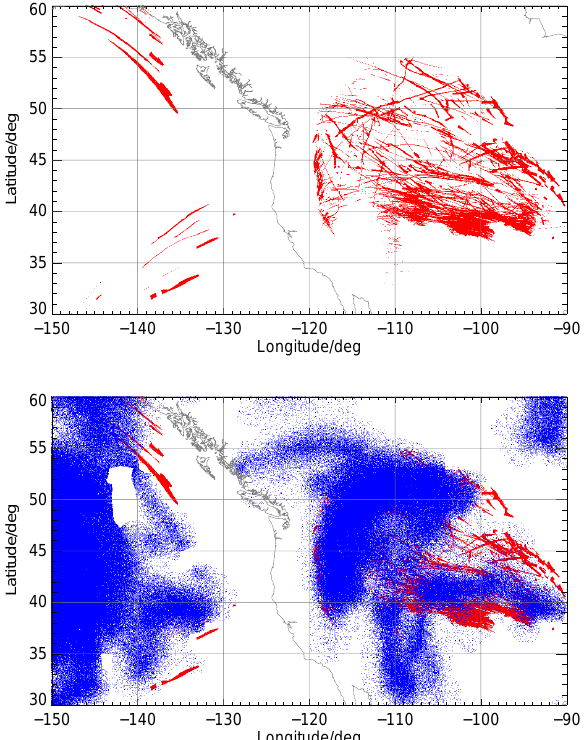
Fig. 13. Bottom: Dilution versus plume age for various aircraft sizes in comparison to an empirical dilution function Eq. (16) for fixed shear S = 0 . 002s − 1 and Brunt-Vaisaila frequency N BV = 0 . 01s − 1 . Top: Dilution versus plume age for a large aircraft, for different shear S (full curve: 0, dashed: 0.005s − 1 ), and different Brunt-Vaisaila frequency N BV (red: 0.001s − 1 , black: 0.01s − 1 ), in comparison to the empirical dilution function. Table 3. Aircraft parameters used for test cases.